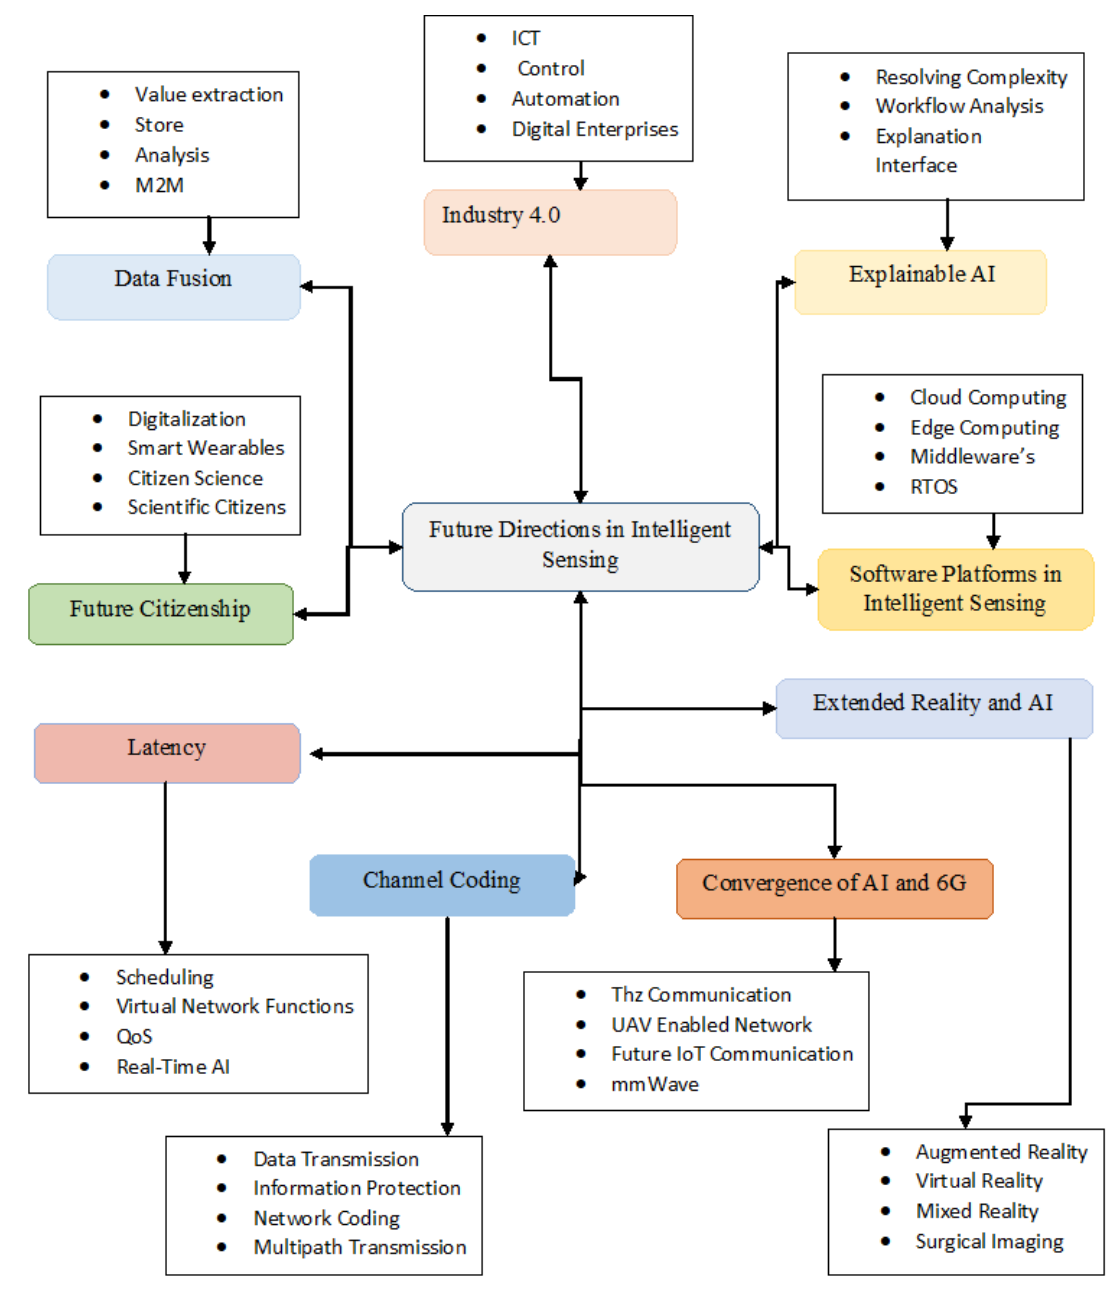
Figure 11. Future